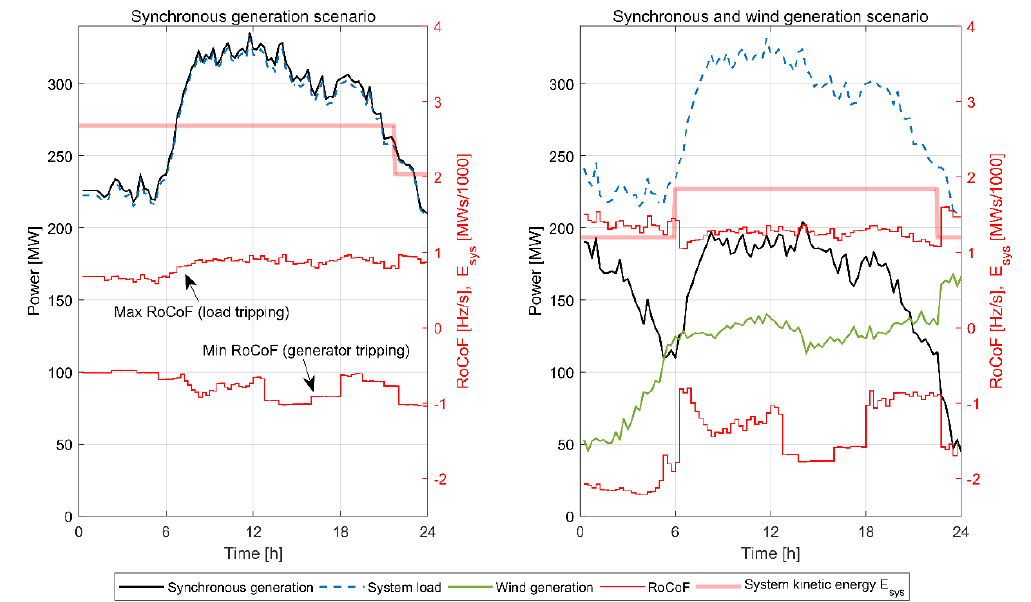
Figure 7. Generation and consumption data (forecast) for the planning timeframe; plots represent data processed in Step 1 of the proposed methodology.